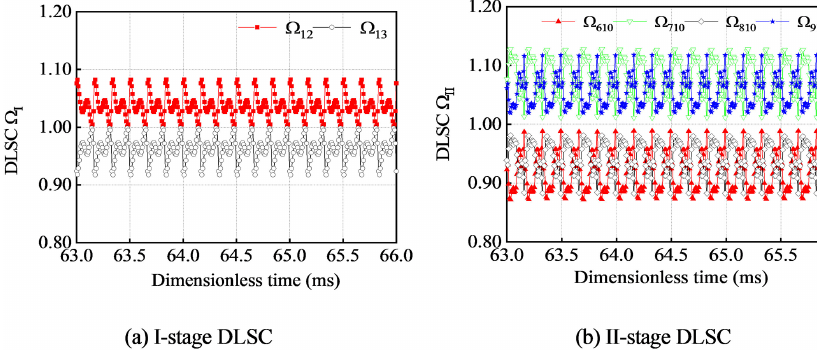
Figure 9. DLSC changed with dimensionless